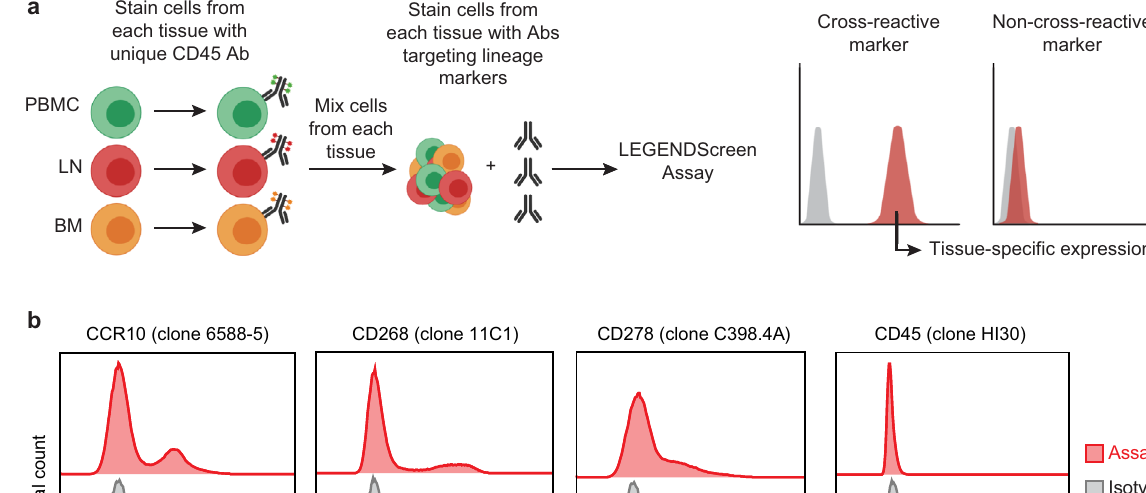
set out to de fi ne new markers for LLPC in NHP. We used a two- pronged approach towards marker discovery employing both a semi-biased ( fl ow cytometry with known antibodies) and unbiased method (multi-modal single-cell pro fi ling) with the semi-biased method informing our unbiased method. For the semi-biased method, we used a high-throughput fl ow cytometry